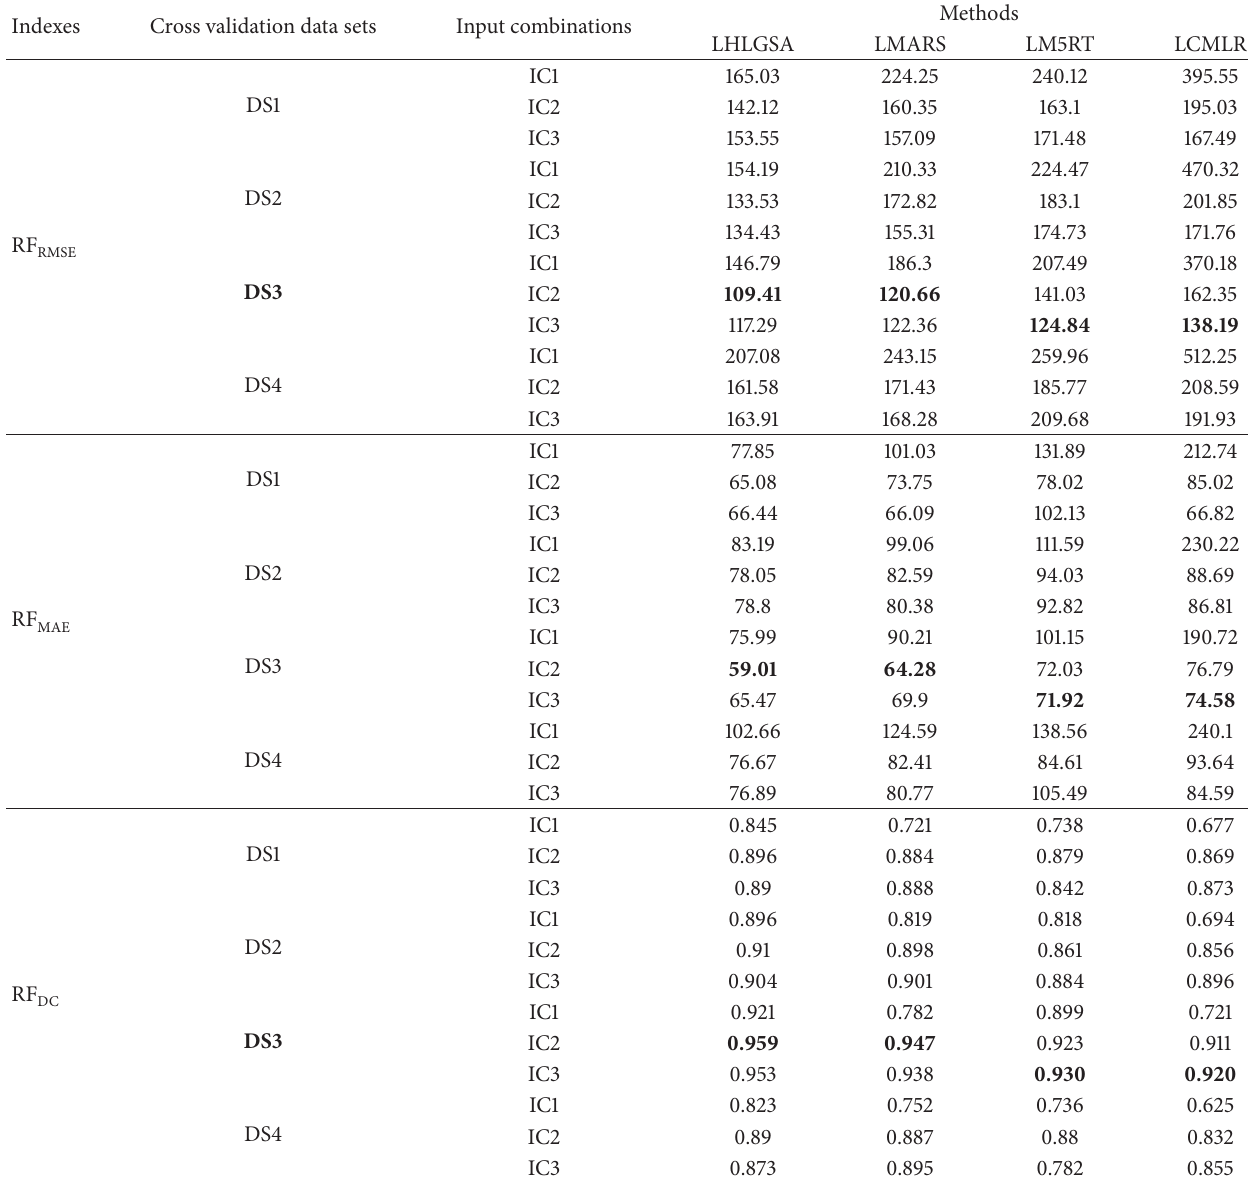
Table 6: Comparison of the LHLGSA, LMARS, LM5RT, and LCMLR methods: Shyok